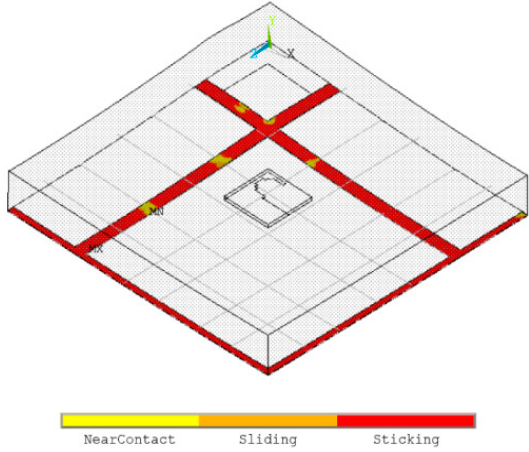
Figure 29. Final stage of CFRP laminates debonding in BN slab model.